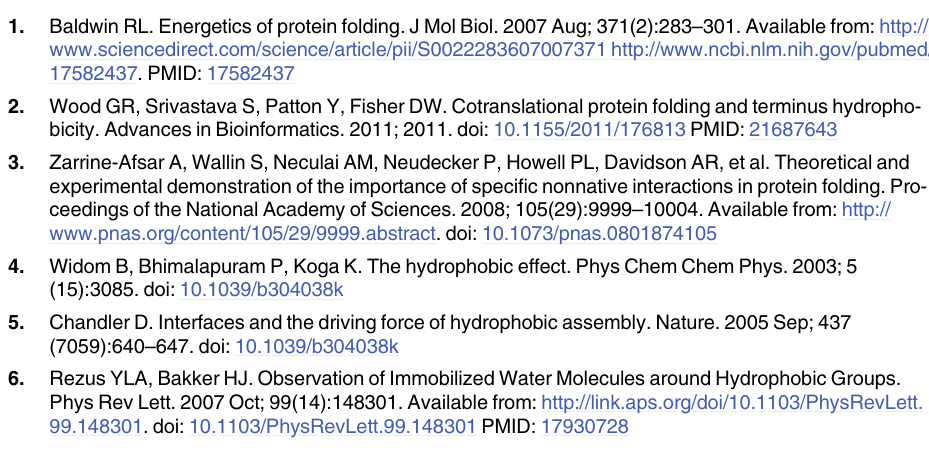
S11 Fig. Scaled area based free energy estimates for classes of amino acids reference cor- rected. Points show the free energy estimates for each temperature bin, lines are fitted with a parabola, consistent with the potentials found in [10]. S12 Fig. Scaled area based free energy estimates for classes of amino acids not corrected. Points show the free energy estimates for each temperature bin, lines are fitted with a parabola, consistent with the potentials found in [10]. S13 Fig. Scaled area based free energy estimates for all amino acids reference corrected. Points show the free energy estimates for each temperature bin, lines are fitted with a parabola, consistent with the potentials found in [10]. S14 Fig. Scaled area based free energy estimates for all amino acids not corrected. Points show the free energy estimates for each temperature bin, lines are fitted with a parabola, consis- tent with the potentials found in [10]. S15 Fig. Quadratic fits of the temperature dependence of LCW-theory for various sizes. The colored, dashed lines show theoretical predictions based on calculation from LCW-theory [10, 42]. The gray, solid lines, show a quadratic fit to these theoretical predictions.